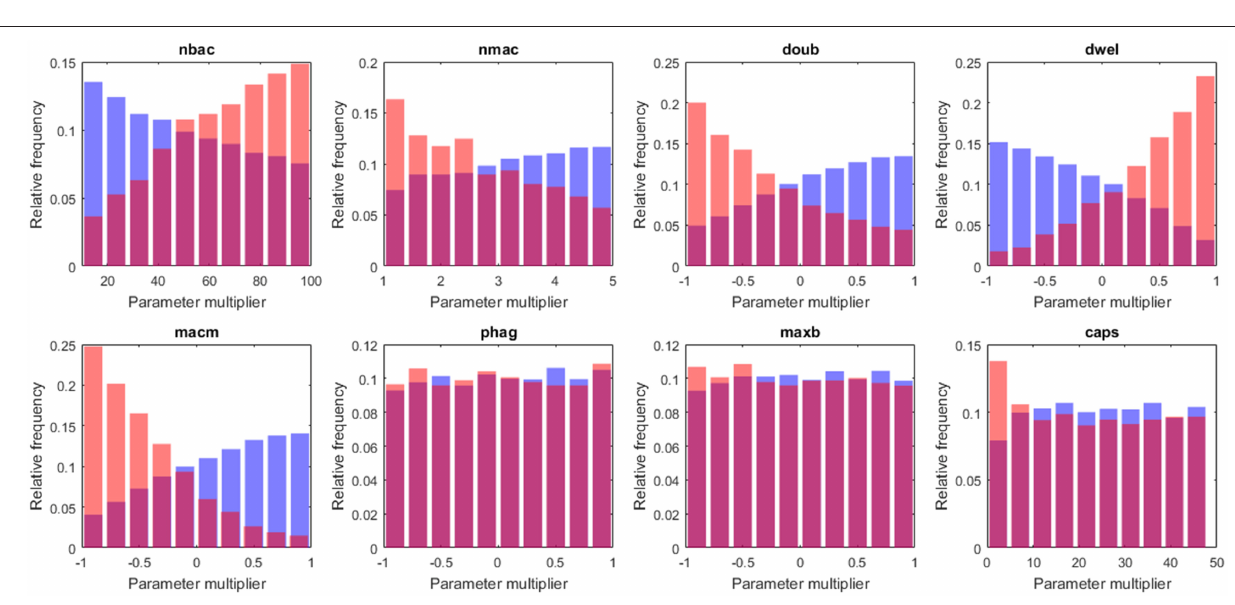
repeated with 2 · 10 4 more solutions, with 10 repetitions each obtained with this new version of the model. When the trade- off between protection against macrophages and removal by the